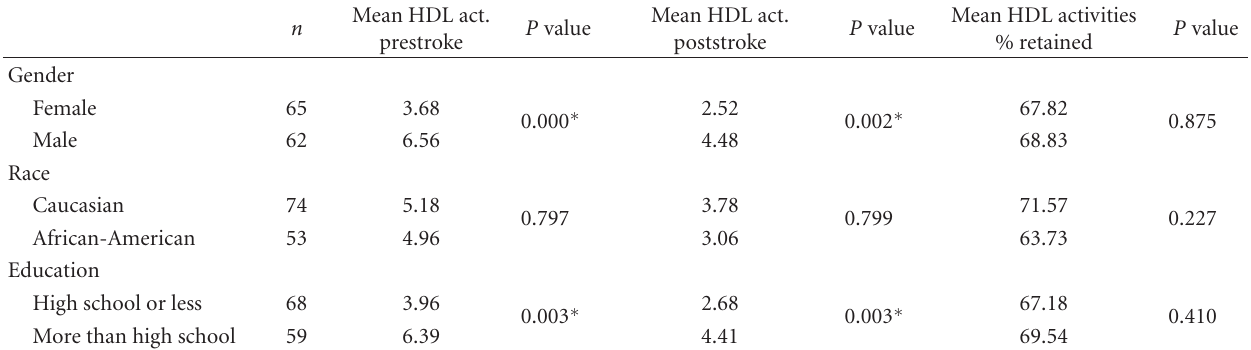
Table 2: Comparison of mean pre- and post-mild stroke HDL activities and % retained by gender, race, and education, N = 127. n